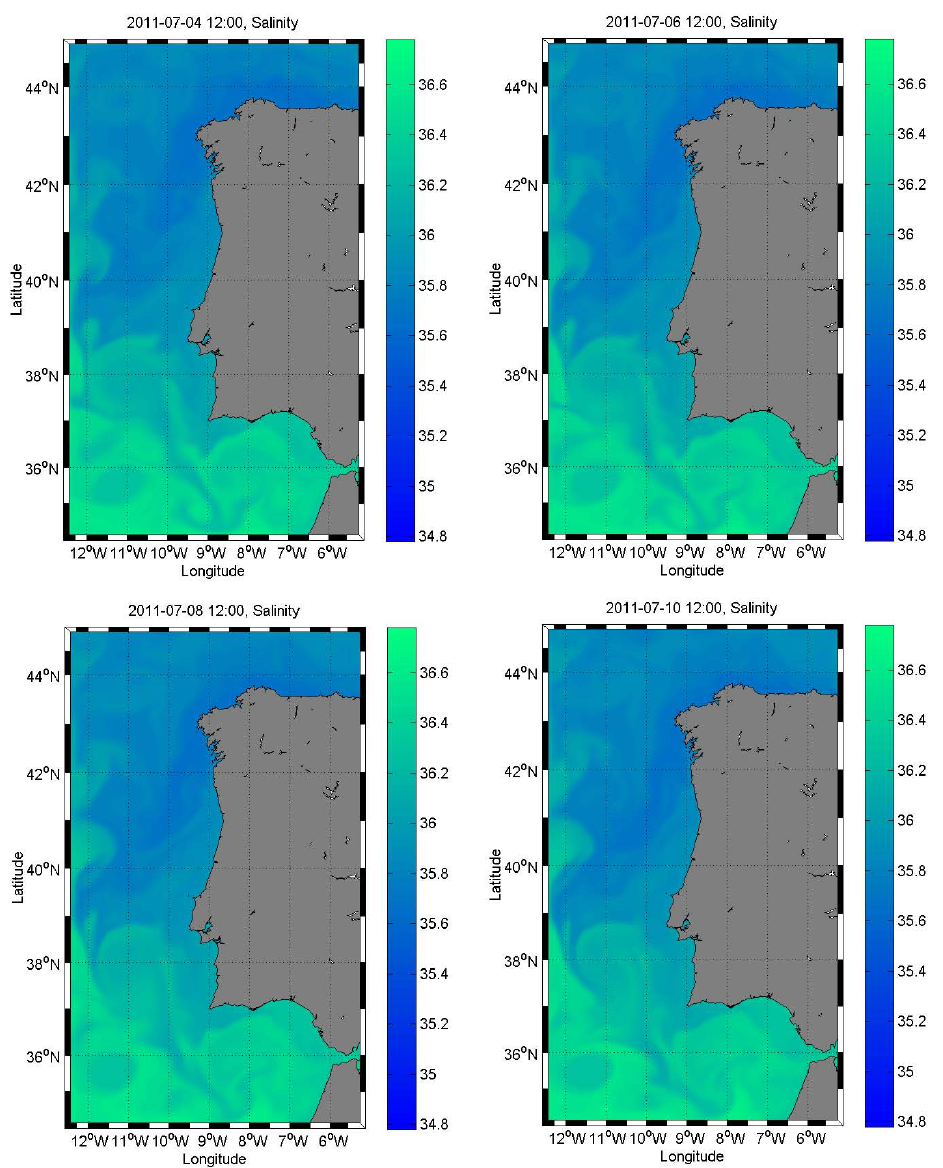
Fig. 6. Snapshots of sea surface salinity predicted by the model from 4 to 10 July 2011.